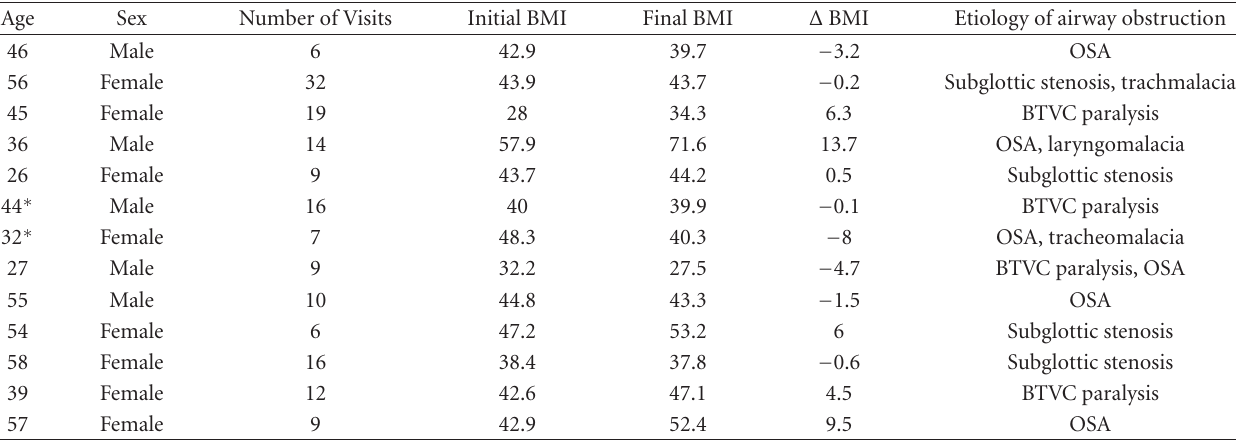
Table 1: Demographics and weight loss